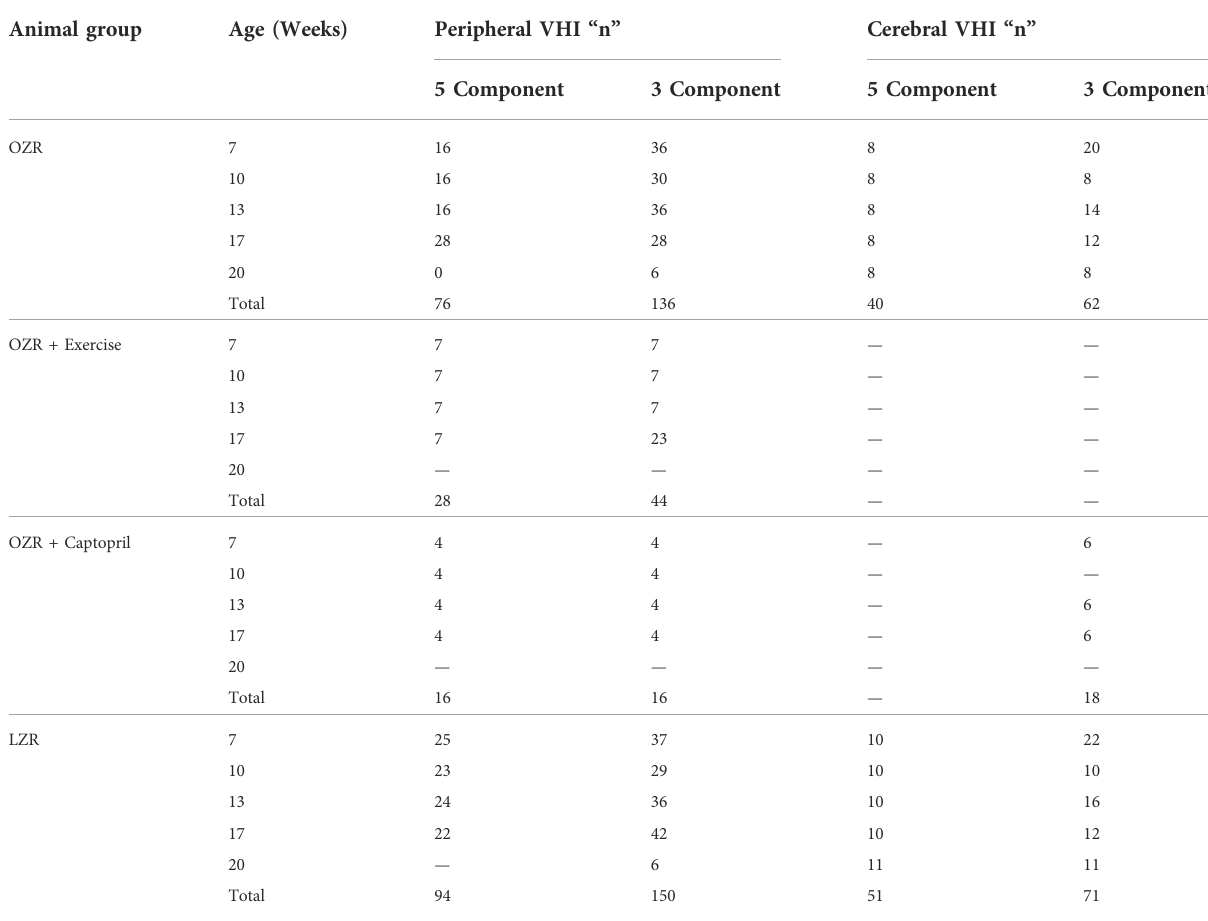
TABLE2Animalnumbersusedinthepresentstudy.Dataarepresentedforeachgroupofanimalsandateachageforboththeperipheralandcerebral vascular health index (VHI) calculations. Animal